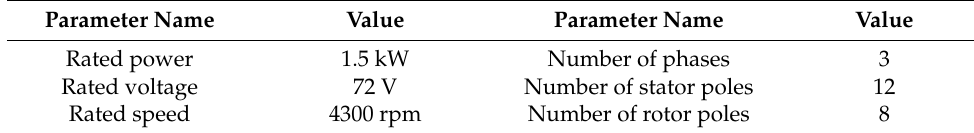
Table 1. Parameters of the three-phase switched reluctance motor.